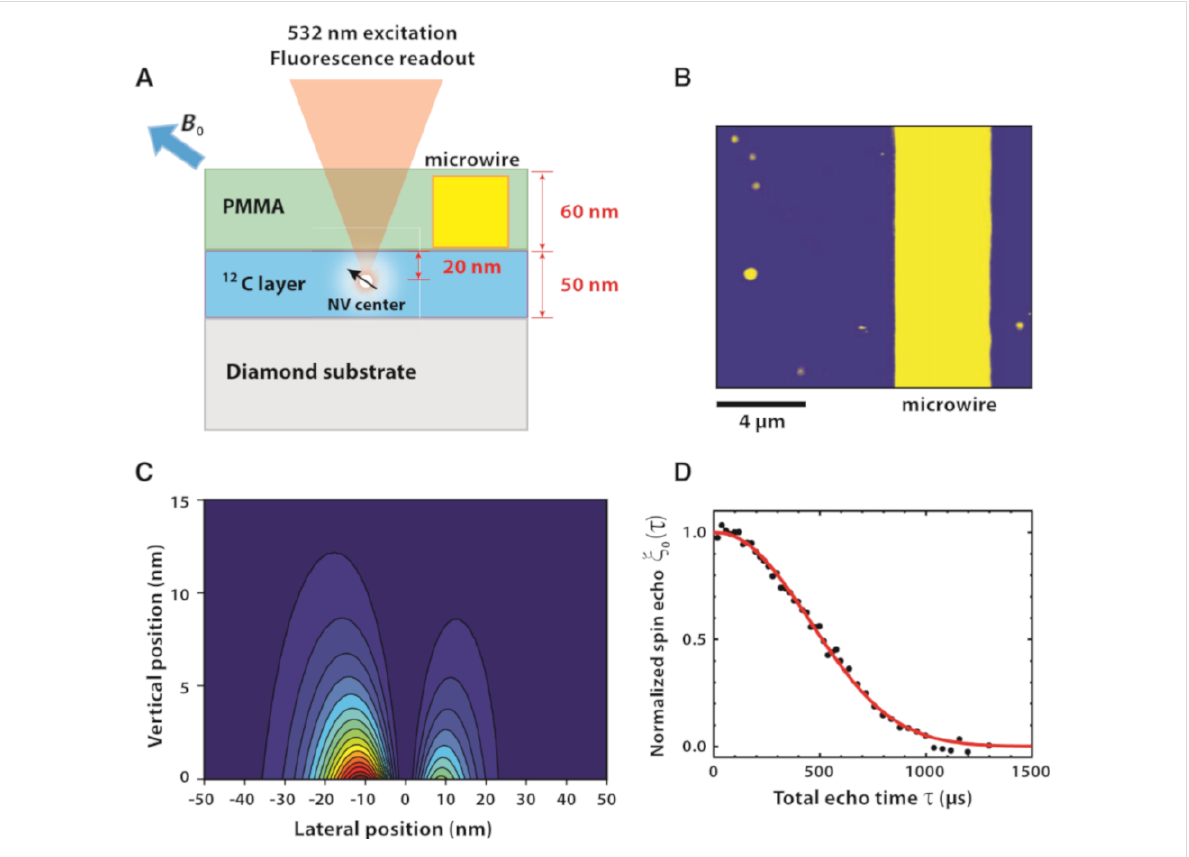
Figure 4: NV-NMR detection system schematic of [73]. Image reprinted with permission from [73], copyright 2013, AAAS. (A) 12 C diamond layer with NV center spin at [111] orientation embedded at 20 nm depth. Proton NMR is detected in a PMMA layer. (B) Sample surface from fluorescence imaging, with microwire and NV center (circled). (C) Proton detection sensitivity dependence from space along the PMMA layer cross-section. 50% of the proton signal comes from a (24 nm) 3 volume. The NV center axis is 54.7° tilted from surface normal, originating two lobes as shown. (D) Normal- ized spin echo response vs total echo